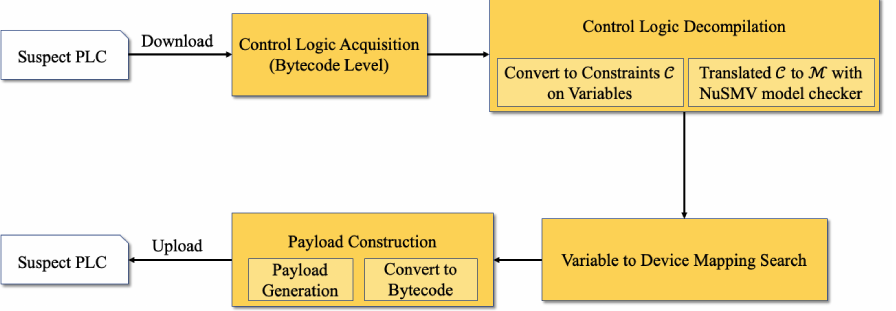
Figure 4. The Specific Process of